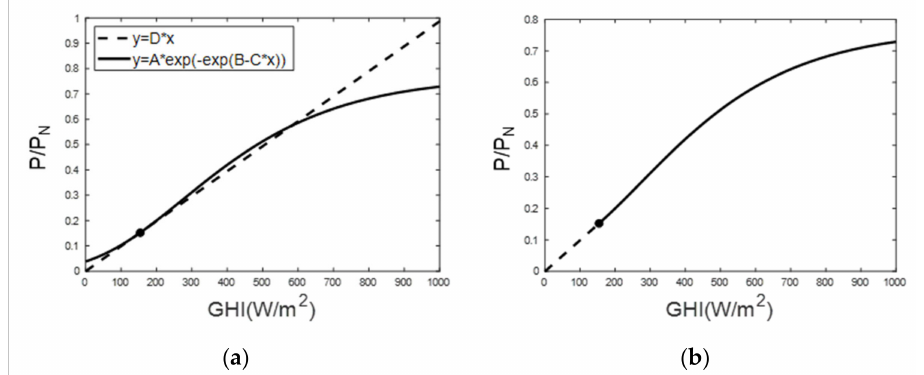
Figure 4. Conjoint process of a linear line (dashed line) and a Gompertz curve (solid line). The line and Gompertz curve appear separated in ( a ) and conjoined in ( b ).